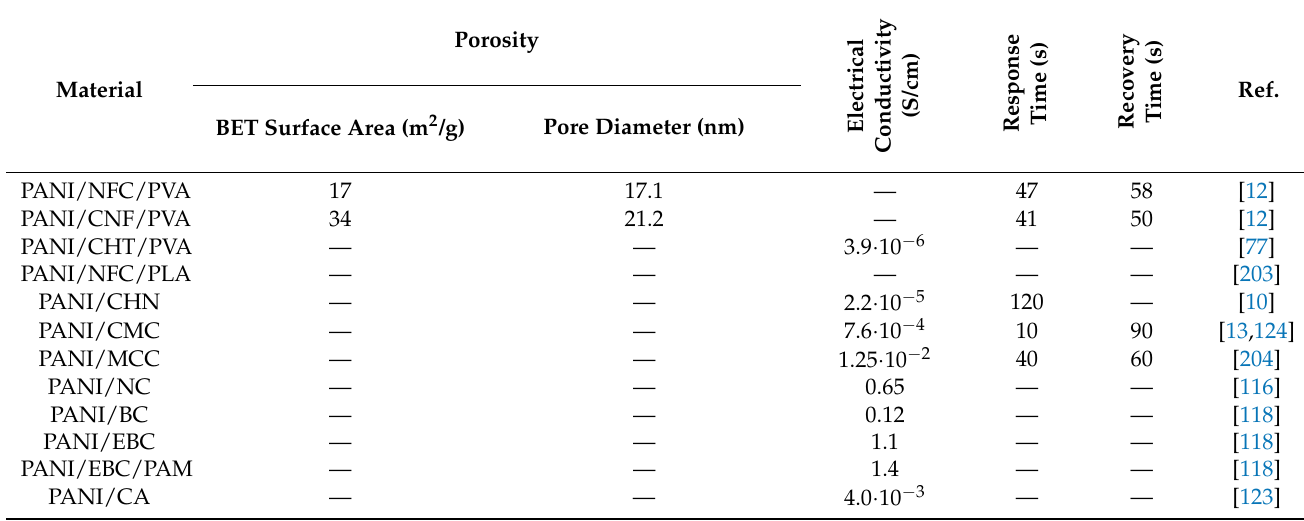
Table 9. PANI/biopolymer humidity sensing materials and their relevant